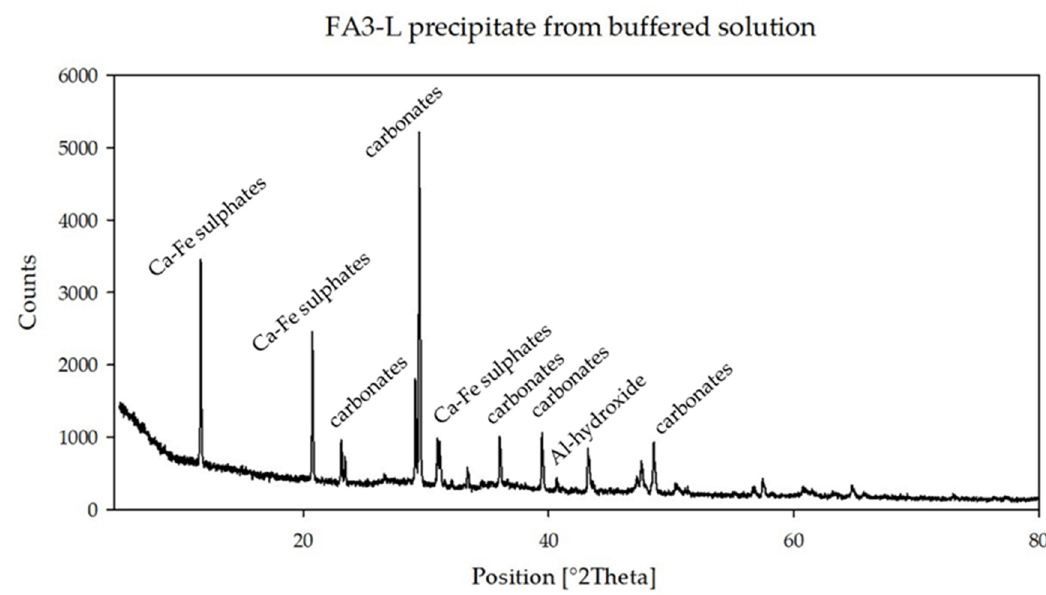
Water 2021 , 13 , x FOR PEER REVIEW